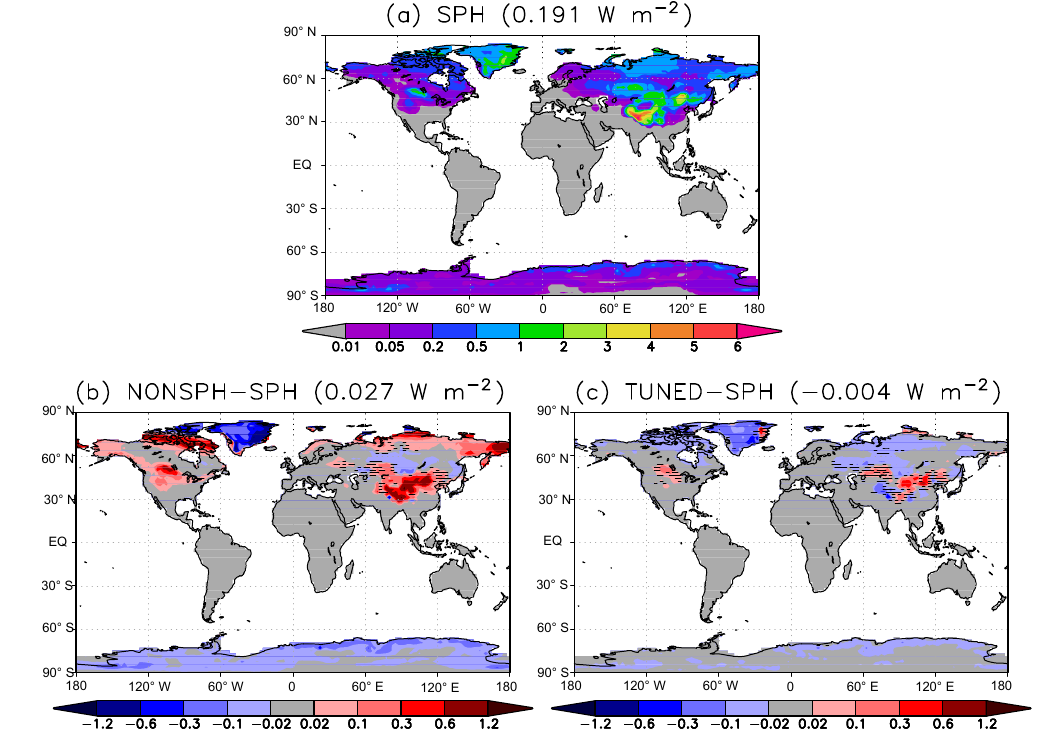
Figure 12. (a) Annual-mean surface radiative effect of absorbing aerosols in snow on land in the SPH experiment (Wm − 2 ). (b) The cor- responding differences between the NONSPH and SPH experiments, and (c) between the TUNED and SPH experiments. Global land-area mean values are given in the panel titles. Hatching indicates differences that exceed the threshold for colour shading (0.02Wm − 2 ) but are not significant at the 5%